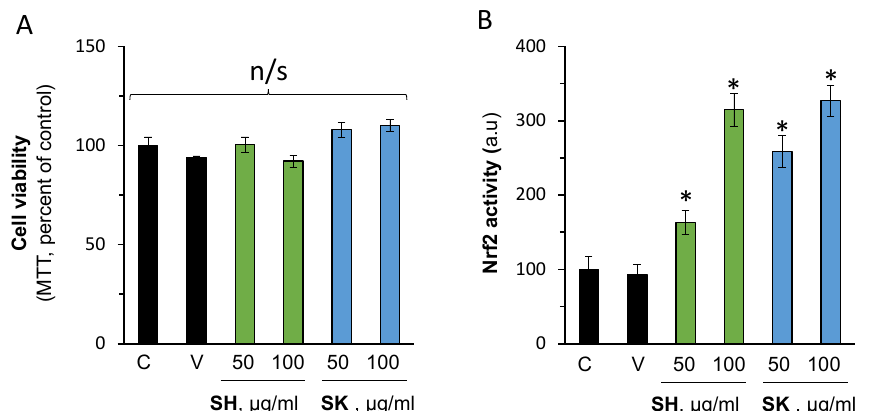
Figure 5. SH-29 and SK-119 activate Nrf2 in vitro. HaCaT keratinocyte cells were treated w/o or with 50 or 100 µ g/mL of SH-29 or SK-119. After 2 h, cell viability was determined by the MTT assay ( A ). Concomitantly, the nuclear fraction was isolated, and Nrf2 activation was determined as written in the material and method section above ( B ). n = 3; * p < 0.05 for signification different from naïve control cells. C—control; V—vehicle, DMSO at 0.1%; SH for SH-29 and SK for SK-119.